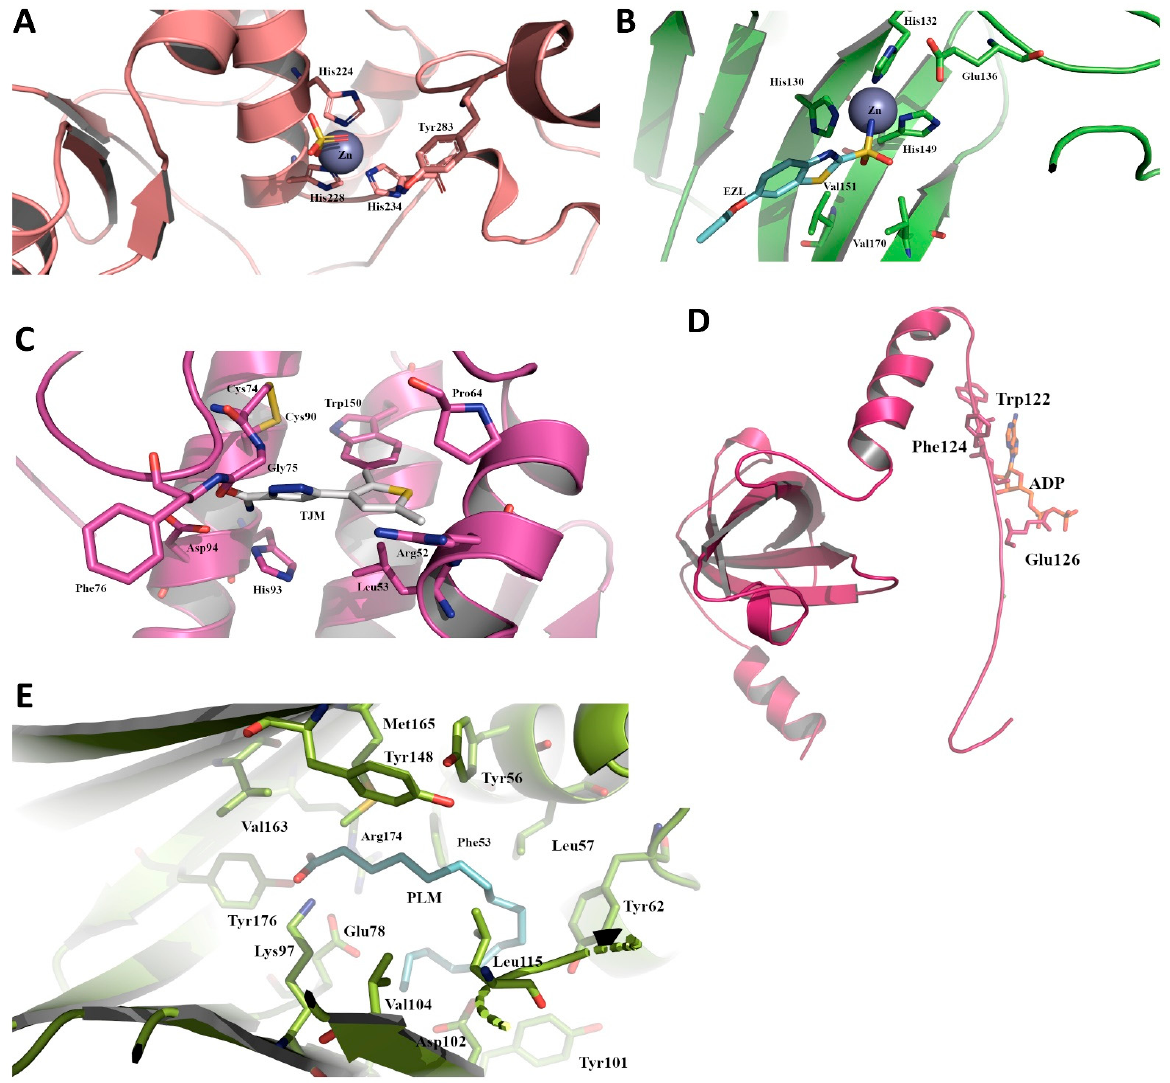
Figure 6. The predicted active site domains of some of the differentially expressed parasite genes, including ( A ) zinc-dependent metalloprotease astacin (ASTL), ( B ) carbonate dehydratase (CA2), ( C ) phospholipase A2 (PLA2), ( D ) glutamine synthetase, beta-grasp domain protein (GLUL), and ( E ) fatty acid-binding protein 3 (FABP3). Bound molecules identifying the active site domains were derived from the template structures that our models were based on, including: the zinc and sulfate molecules in astacin from a zinc metalloprotease from zebrafish (PDB code 3LQB [38]); ethoxzolamide (EZL); a known carbonic anhydrase inhibitor and zinc bound to carbonate dehydratase (PDB code 3MDZ); a pyrazole-based inhibitor 5-(2,5-dimethyl-3-thienyl)-1h-pyrazole-3-carboxamide (TJM) in the phospholipase model (PDB code 4UY1 [37]); a portion of the ADP binding domain present on the glutamine synthetase; the beta-grasp domain derived from human glutamine synthetase (PDB code 2QC8 [39]); and palmitic acid bound to human myelin protein P2 (PDB code 5N4P [36]). Residues within 4 Å of the bound and superimposed molecules are pictured as sticks. All figures were prepared using Pymol.